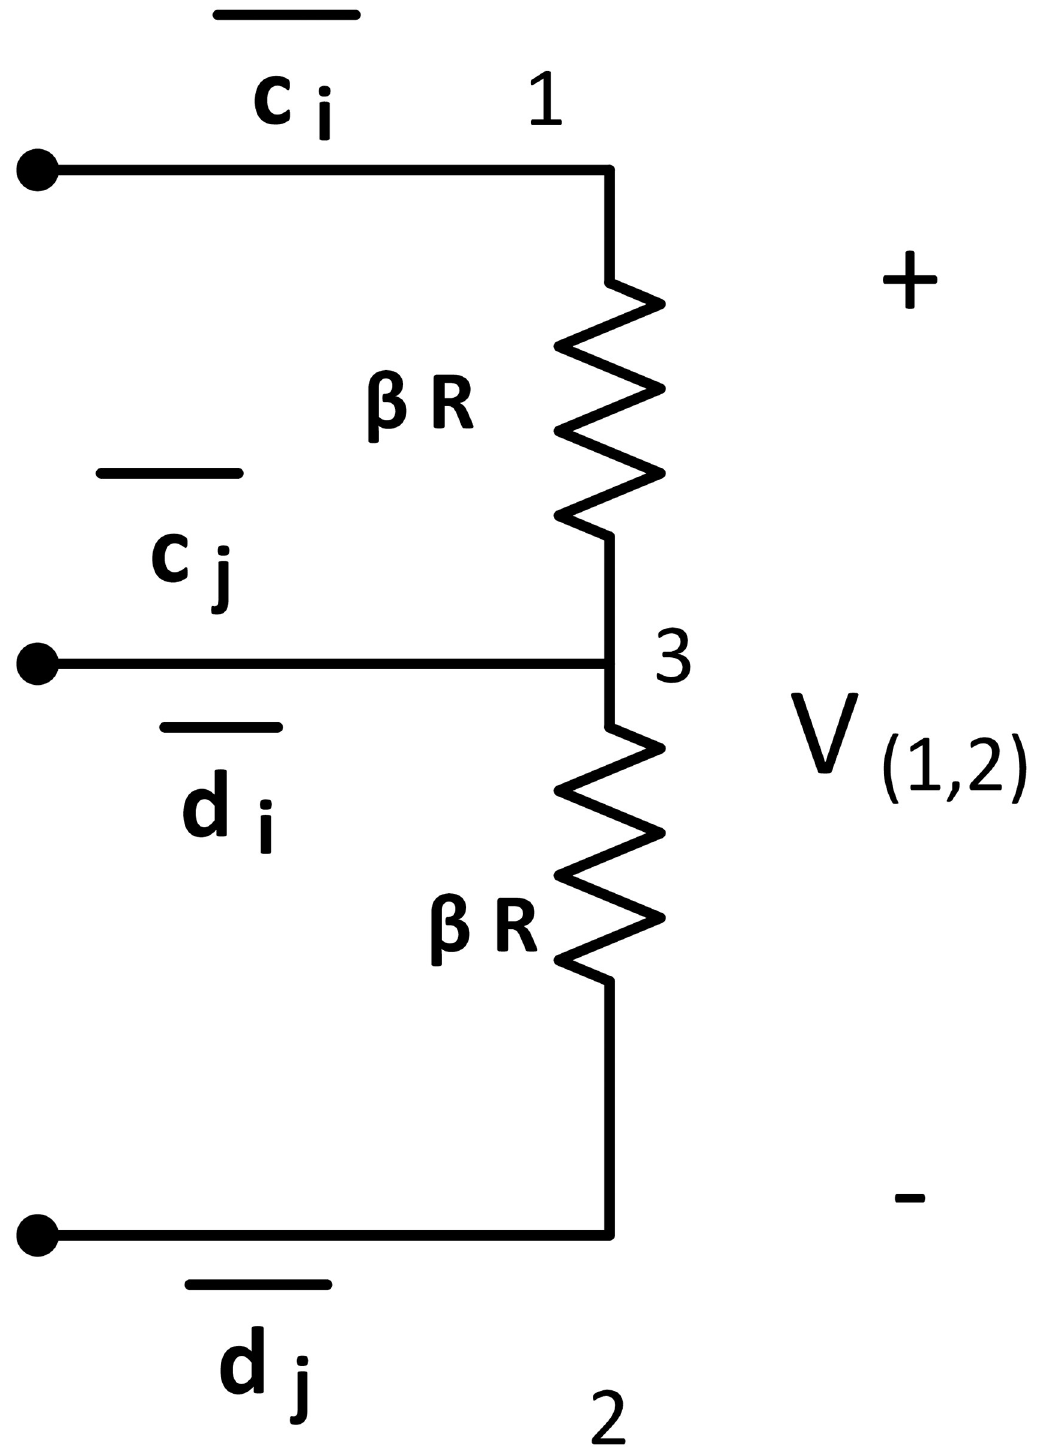
Fig 4. OR tile. OR tile consists of two β R resistors connected in series. It has two input nodes across {1, 3} and {3, 2} and one output node at {1, 2}. Glues: g ð 1 Þ ¼ f � c location of the